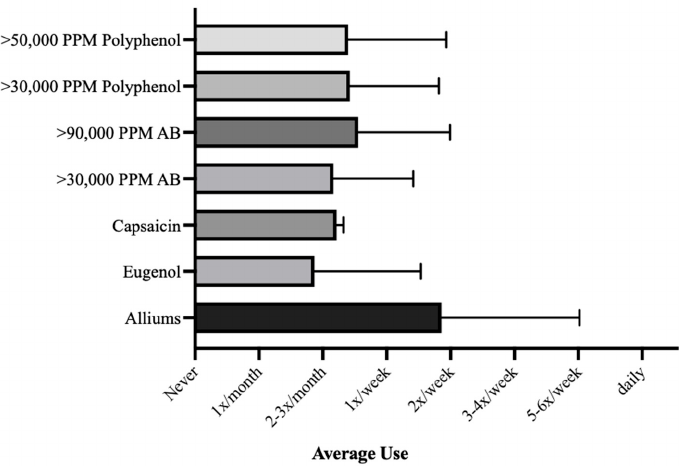
Figure 2. Average frequencies of culinary herb use by phytochemical grouping. Shown are the average frequencies of culinary herb and spice use with standard error bars, ranging from: Never, once per month, 2 to 3 times per month, once per week, twice per week, 3 to 4 times per week, and 5 to 6 times per week. No herb groups averaged daily use.